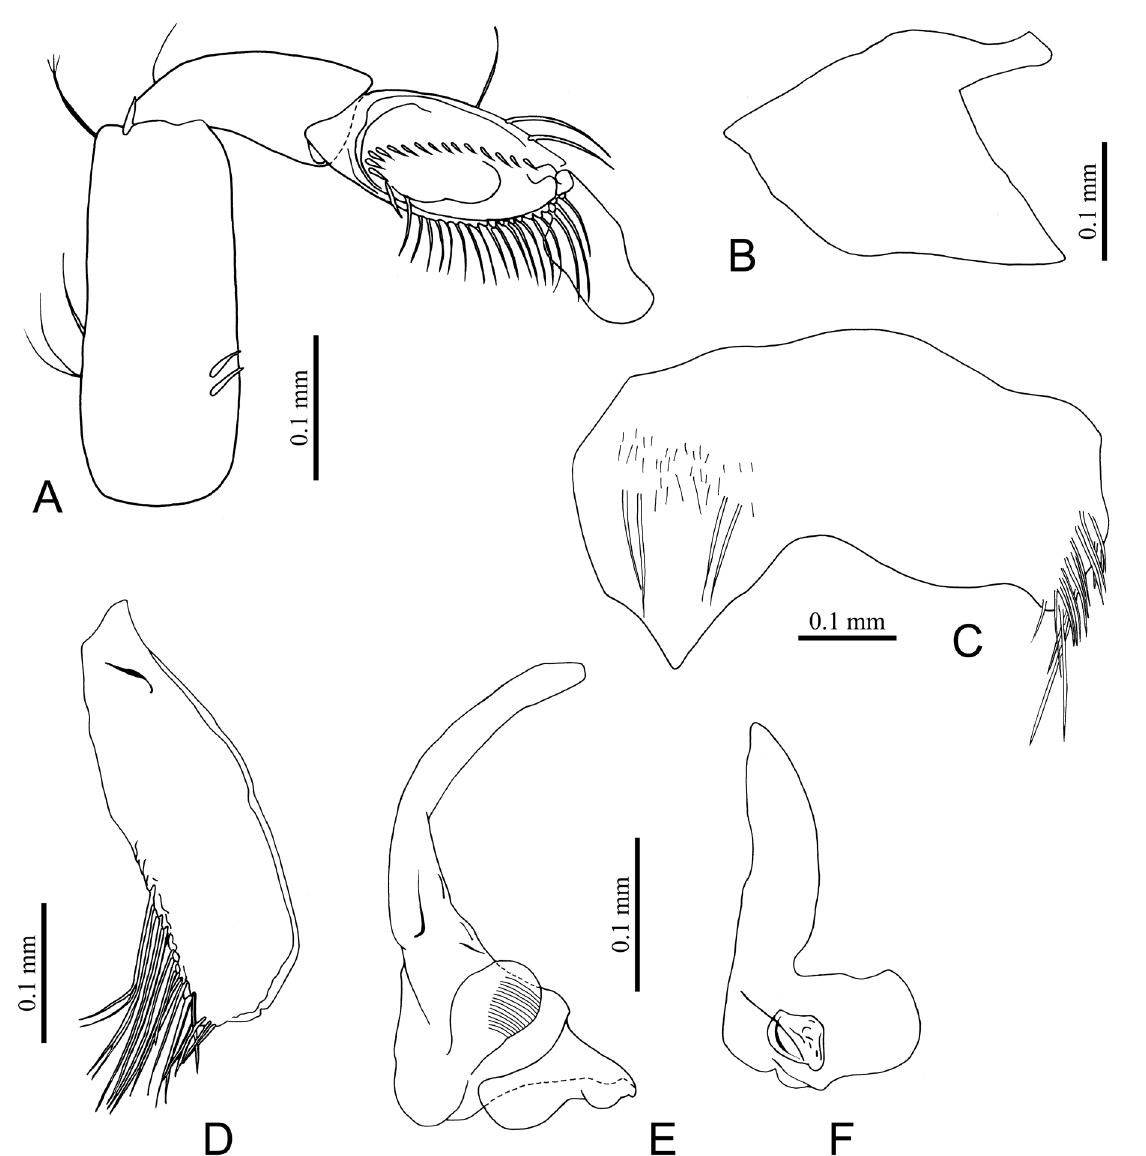
Fig. 8. Morphological features of Micronecta cultellata sp. nov., ♂, paratype (ZVNU). A . Fore leg. B . Prestrigilar flap. C . Sternite VII and median lobe. D . Free lobe. E . Right paramere. F . Left